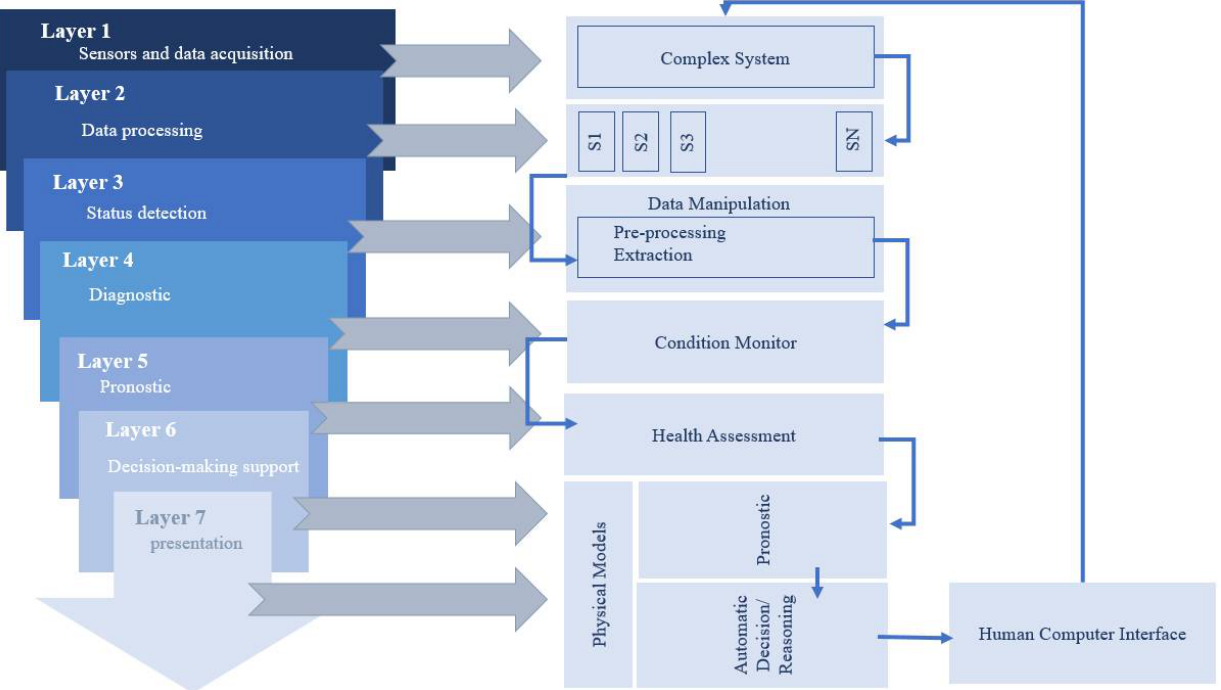
Figure 9. The seven modules of a conditional maintenance system [57] .